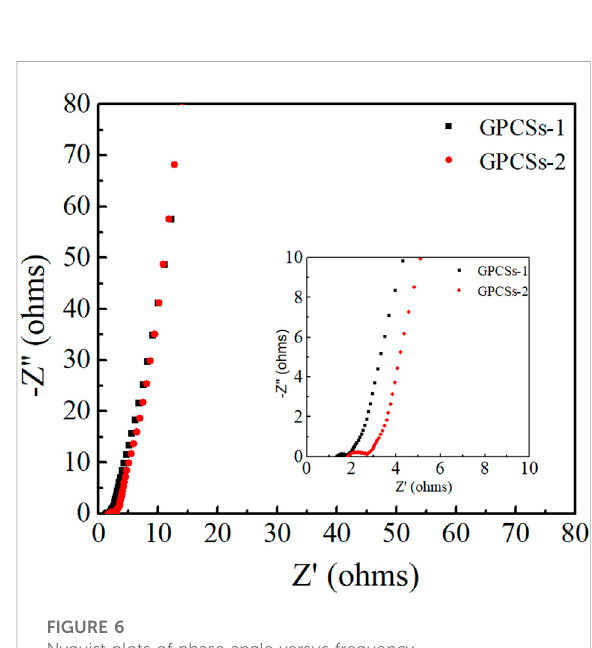
FIGURE 6 Nyquist plots of phase angle versus